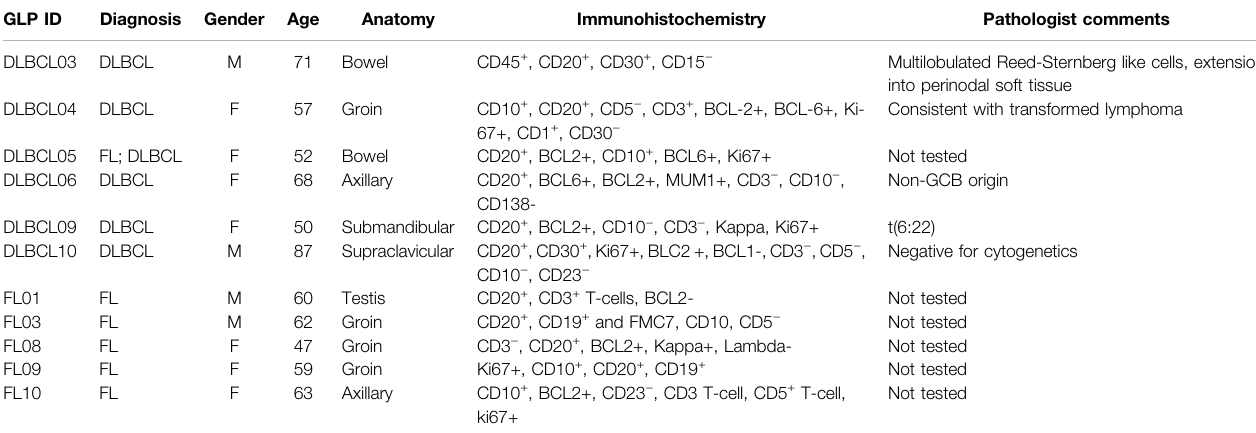
TABLE 2 | Pathology of NHL tumour samples, including immunohistochemistry and comments from pathologist. GLP ID Diagnosis Gender